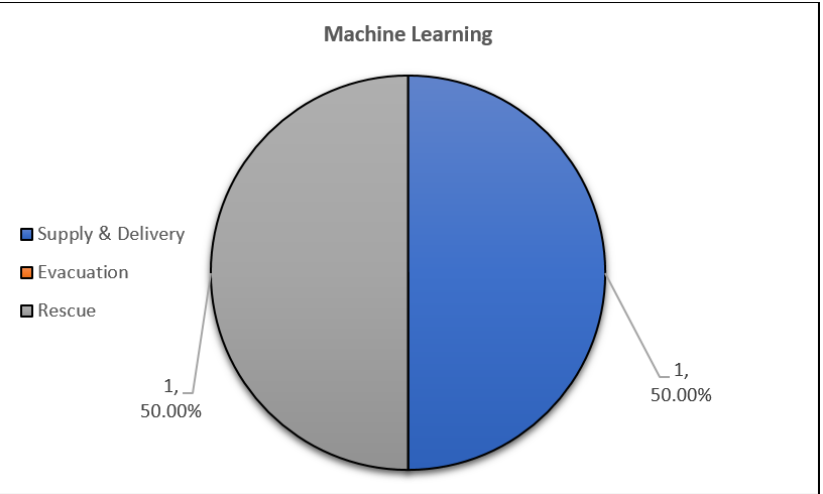
Figure 26. Selected Humanitarian Operation based on Machine Learning (ML) Solution Approach.